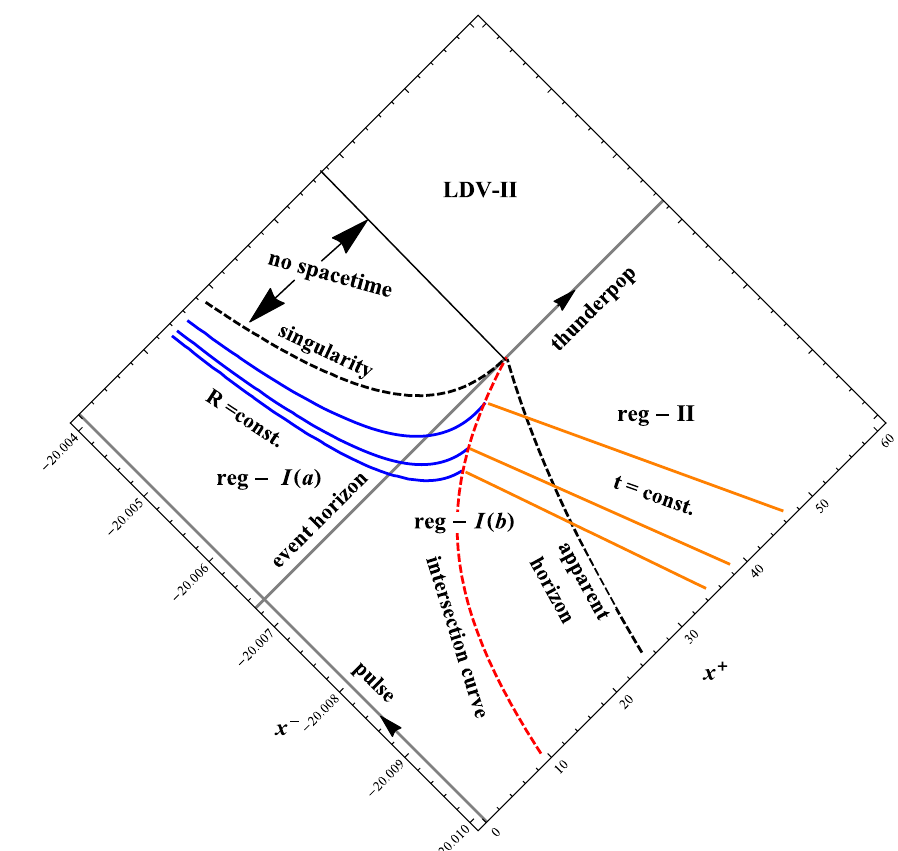
Fig. 3 Spacetime foliation plots for RST model. The family of Cauchy slices are given by R = const . curves inside the apparent horizon joined with t = const . lines outside. We have set = 0 . 1 k = 1 , m = 2 ,(cid:5) = 1 , x + 0 for all plots. Values of curvature R = 50 , 30 , 25 for blue curves from top to bottom. As required for this slicing to be Cauchy, hypersurfaces with larger R (more closer to the singularity) are joined together with larger values of asymptotic Killing time